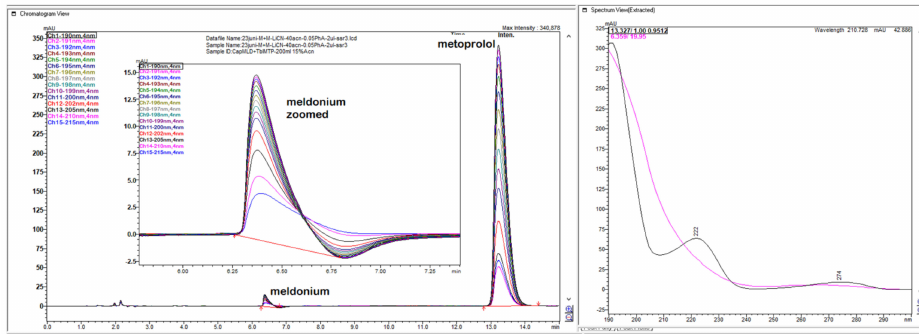
Figure 10. Chromatogram of 250 × 4 mm LiChrospher CN column with 40% ACN and 60% 0.05% NH 4 H 2 PO 4 , with extracted spectrums of meldonium and metoprolol.